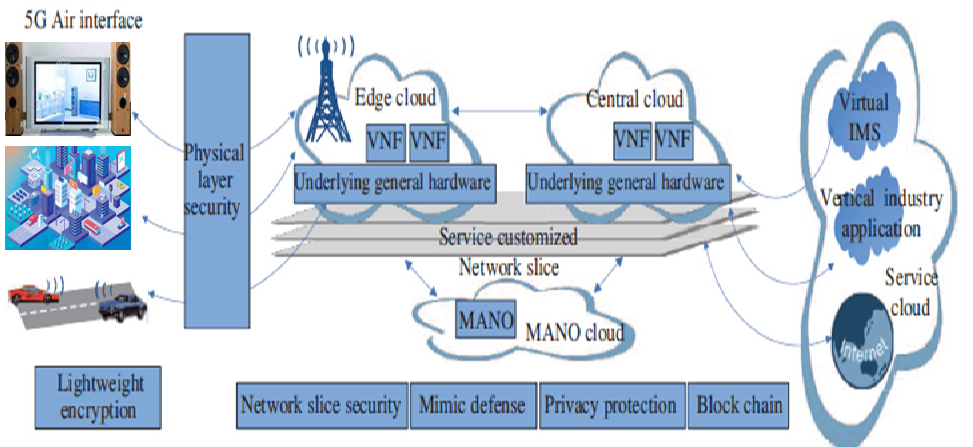
Figure 8. 5G network endogenous defense security architecture (adapted from [26]).